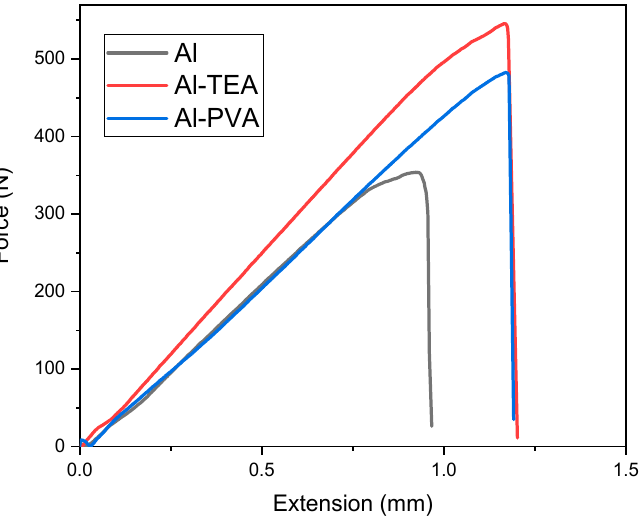
Figure 3. Tensile test measurements for the Al (blank), Al-PVA, and Al-TEA samples bonded by Bison Max Repair commercial adhesive.